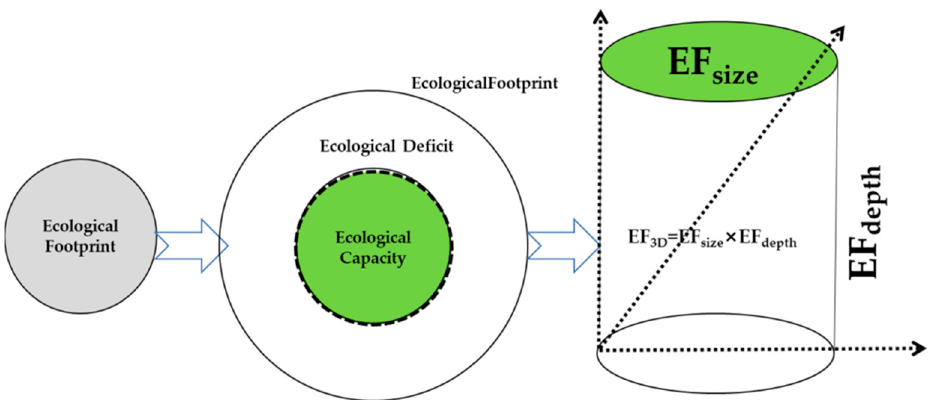
Figure 1. Research framework.